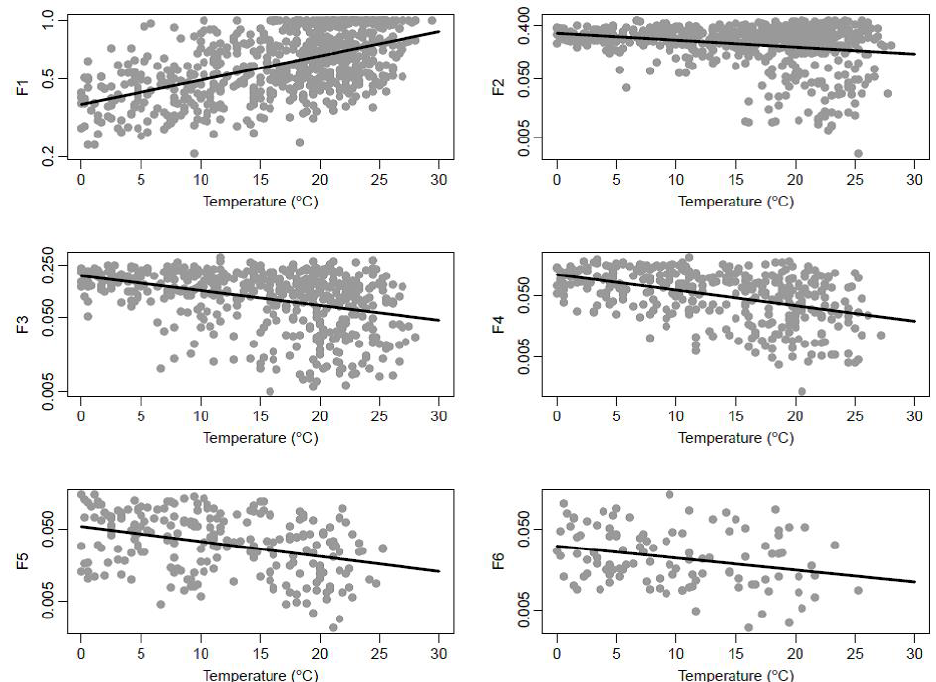
Figure 3. Scaling temporal pattern fractions with temperature for Minneapolis (1948–2014 hourly data). Black lines represent the fitted exponential regression. F represents the number of the ranked fraction.